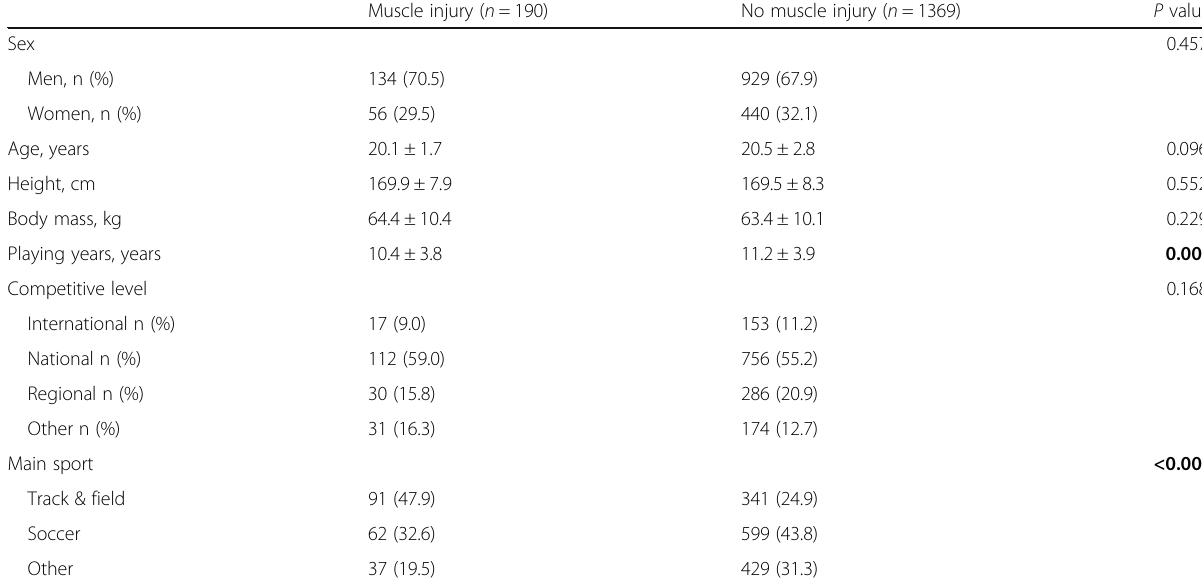
Table 3 Characteristics of subjects in muscle injury and no muscle injury group in Study 2